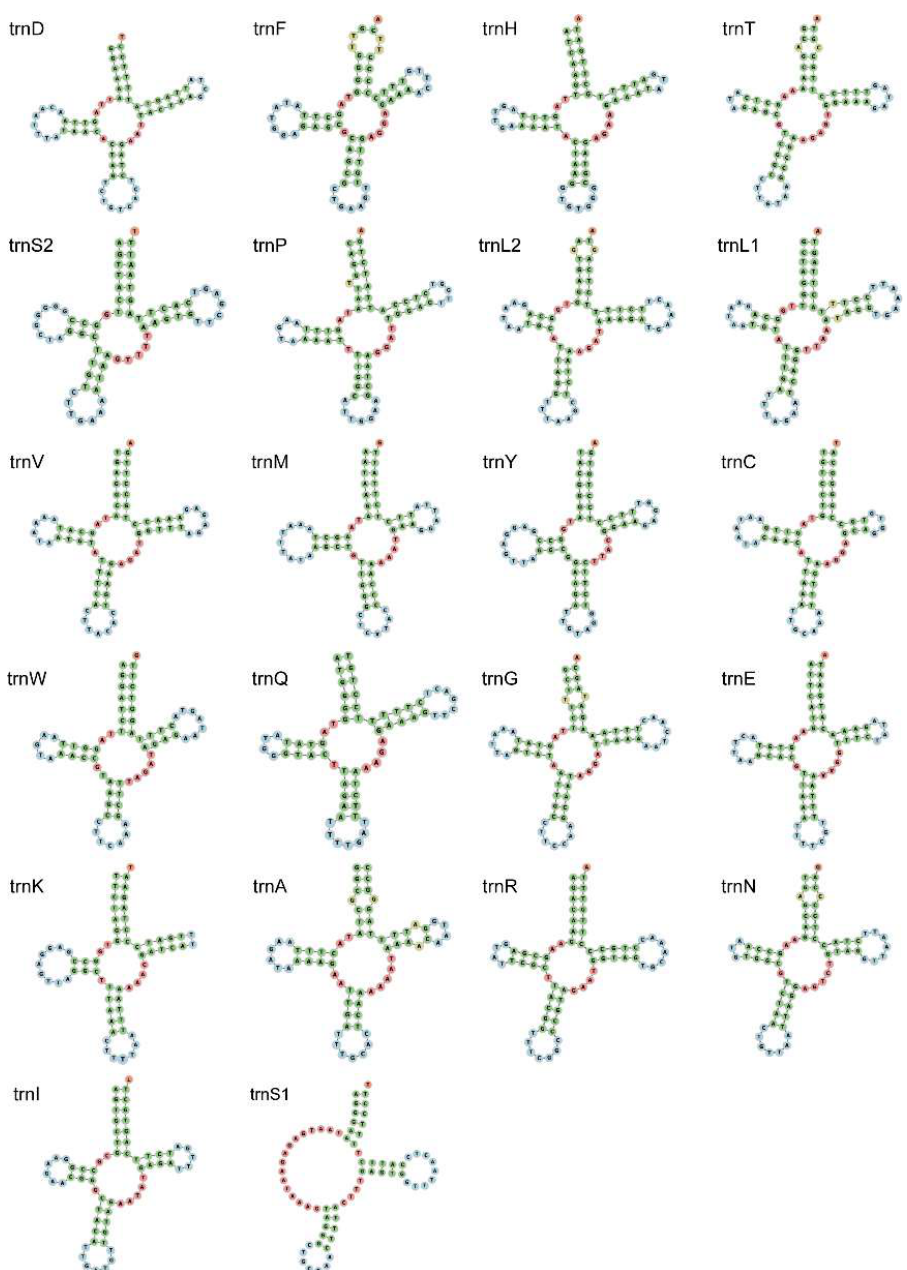
Figure 3. Secondary structure of 22 tRNAs of E. rumphii mitochondrial genome.